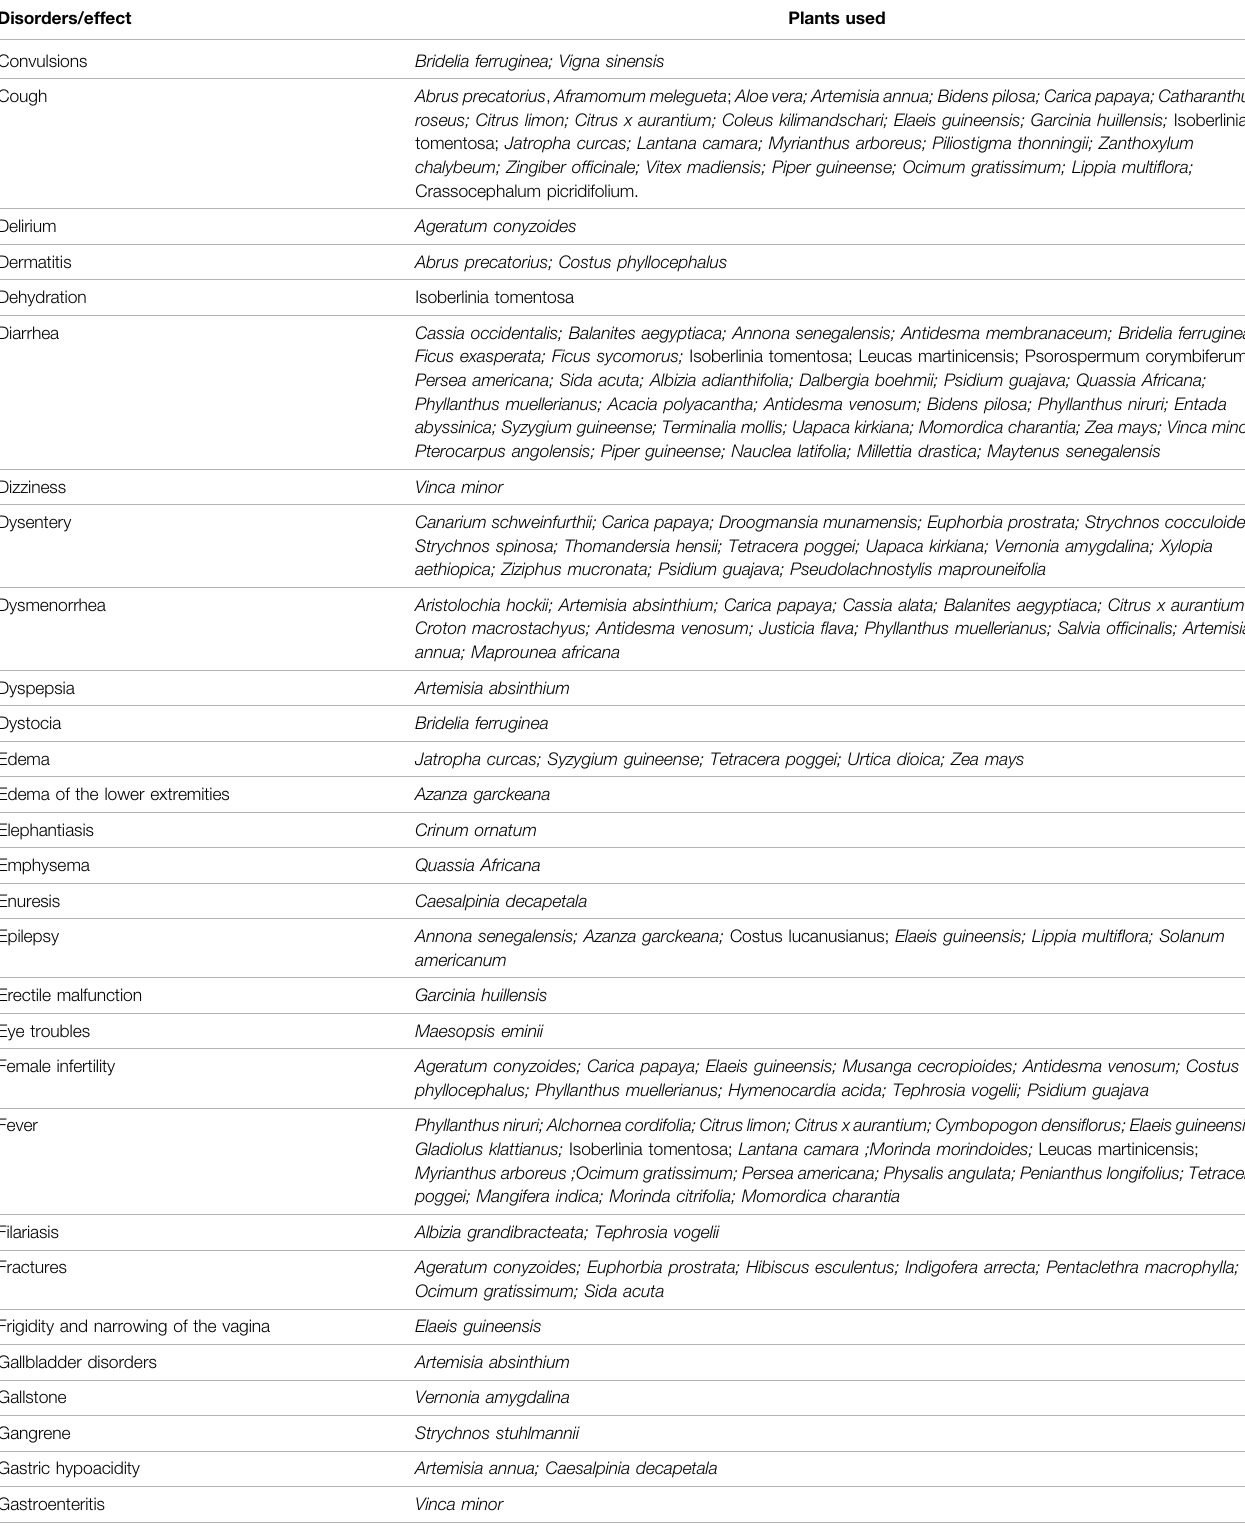
TABLE 3 | ( Continued ) Antidiabetic plants used locally for the treatment of other various